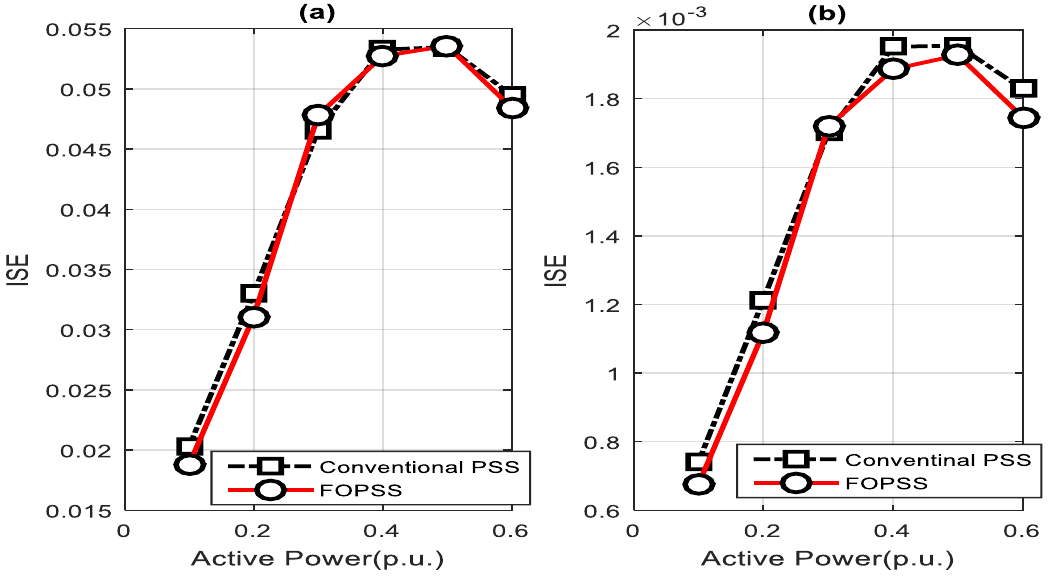
Figure 14. Cost function analysis: ( a ) ISE for output system response; and ( b ) control effort cost function.